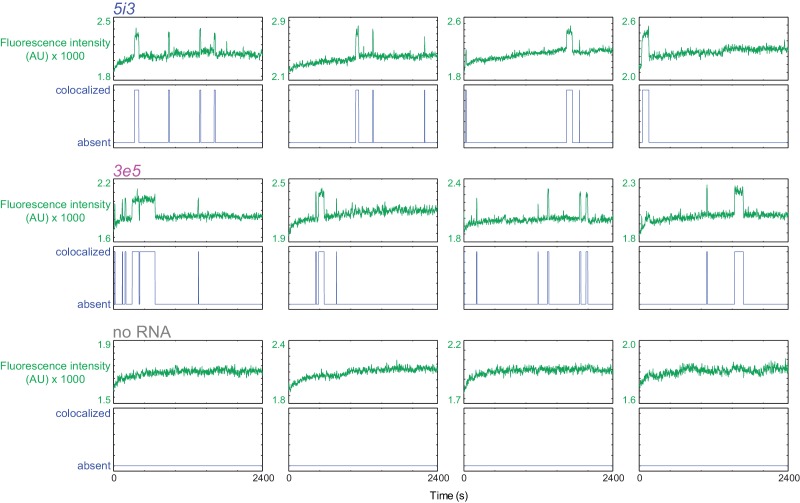
Sample fluorescence intensity traces and detected U1 binding events on 5i3 and 3e5 RNA molecules and at no RNA control locations (see Figure 2).For each location both time records of fluorescence intensity (green) and image-analysis-based detection of a fluorescent spot (blue; colocalization or absence of colocalization; [Friedman and Gelles, 2015]) are shown.